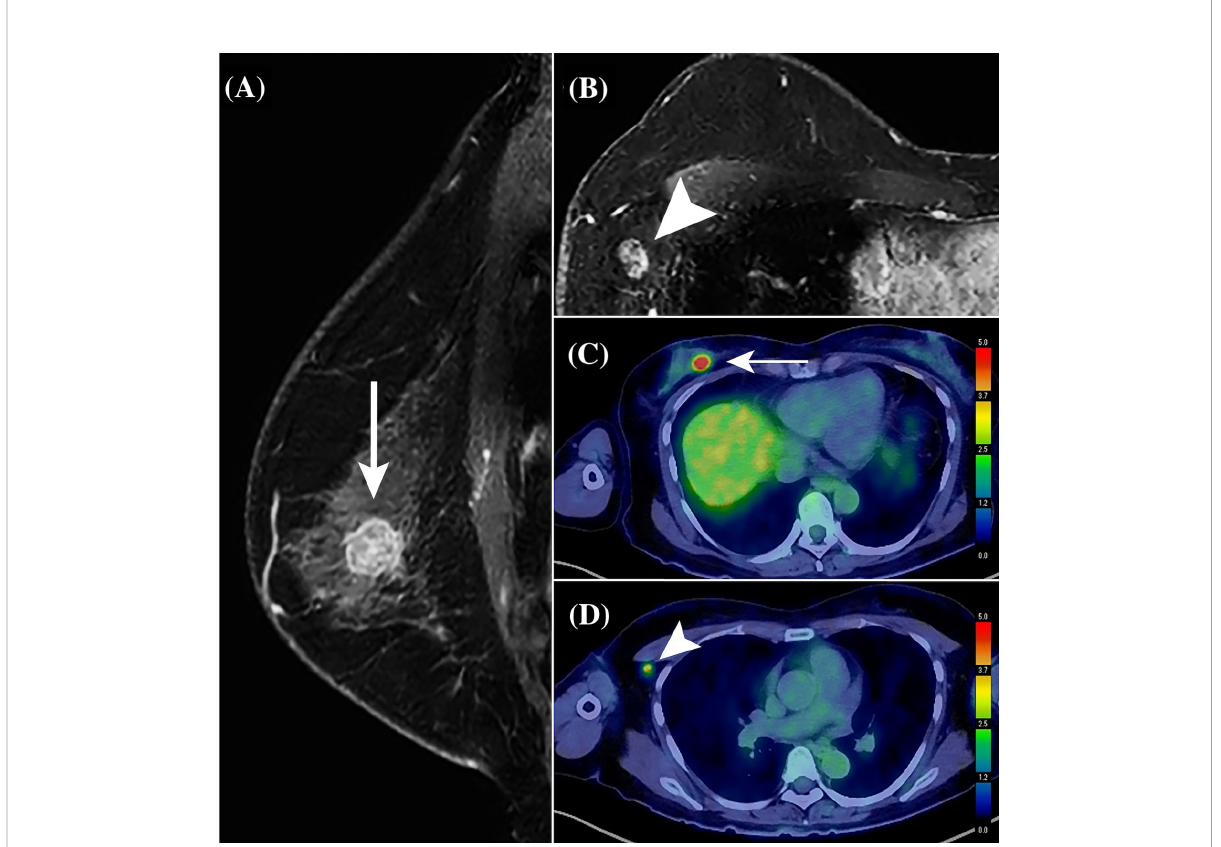
FIGURE 3 Representative contrast-enhanced MR and PET/CT images of a 59-year-old woman with primary breast cancer (pT1cN1aM0, pStage IA; invasive ductal carcinoma; Luminal A-like type; histological grade, II). On using the perioperative risk scoring system for axillary lymph node (ALN) macrometastasis, the patient with a total score of 15 was categorized into the high-risk group. A solitary ALN macrometastasis of 8 mm was detected by sentinel lymph node biopsy followed by ALN dissection. (A) Sagittal contrast-enhanced T1-weighted MR image shows a primary invasive ductal breast cancer in the upper and inner quadrant of the right breast, a 15-mm round mass (white arrow), with heterogenous enhancement pattern. (B) Transverse T1-weighted MR image showing an enlarged ALN exhibiting no fatty hilum, with a cortical thickness of 9 mm (white arrow). (C) PET/CT shows an abnormal FDG accumulation (white arrow) in the right breast mass, with a maximum standardized uptake value (SUVmax) of 9.45. (D) PET/CT also shows marked FDG accumulation in an enlarged ALN (white arrow), with an SUVmax of